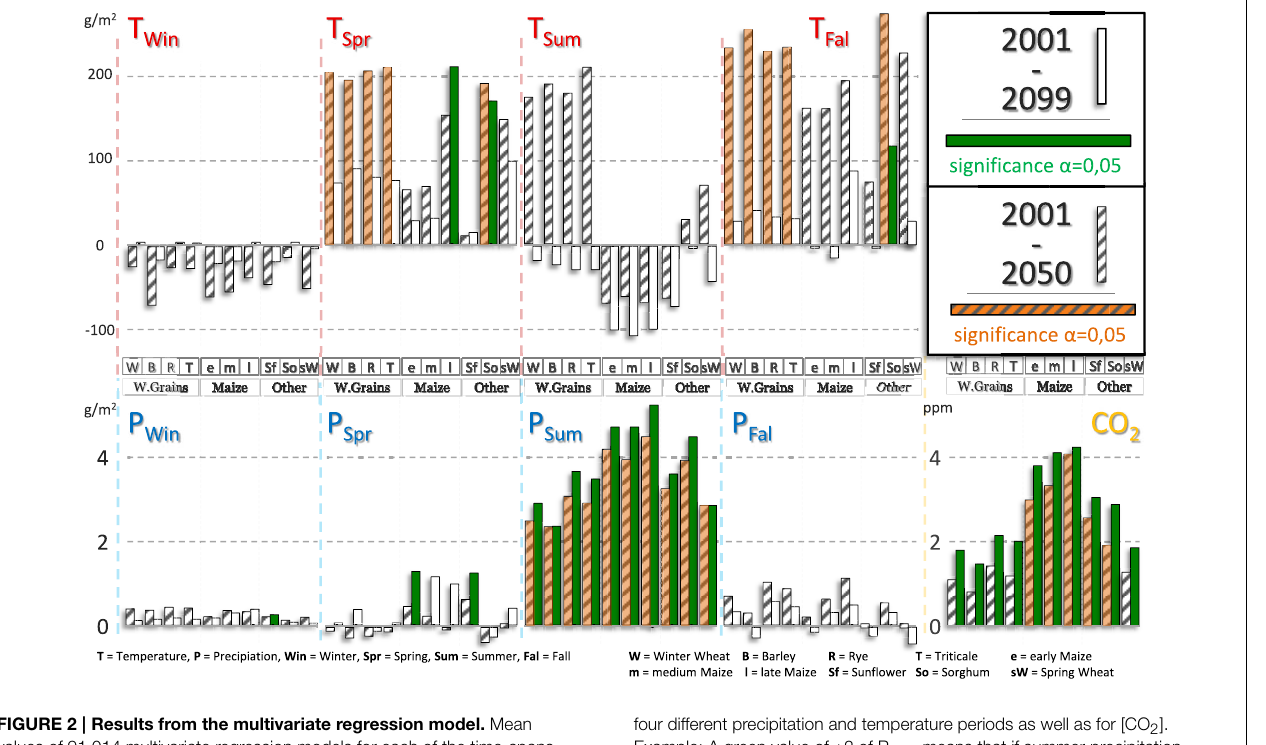
FIGURE 2 | Results from the multivariate regression model. Mean values of 91,014 multivariate regression models for each of the time-spans 2001–2099 and 2001–2050. Bar heights indicate regression strength and direction. Bar color indicates significance. Values are given for each crop for